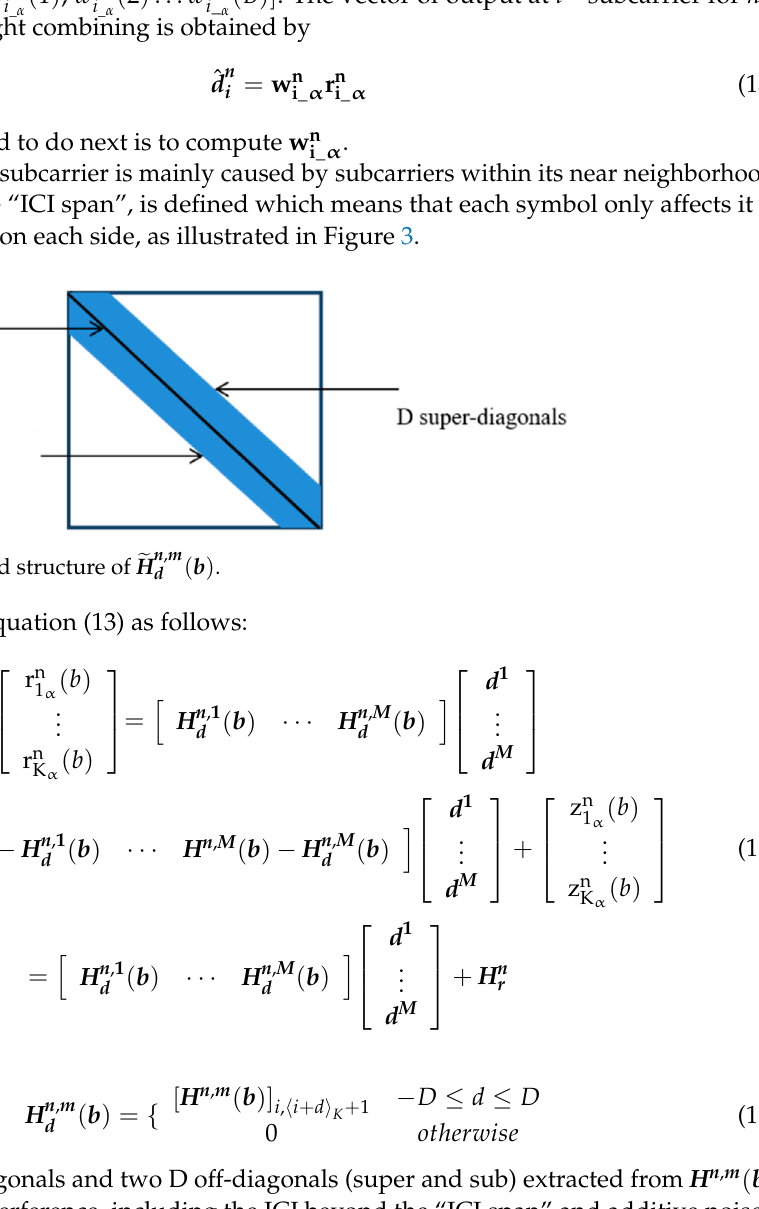
contains main diagonals and two D off-diagonals (super and sub) extracted from H n , m ( b ) , while H n r is the interference, including the ICI beyond the “ICI span” and additive noise. Then, the output vectors related to i th subcarrier r n (16), leading to